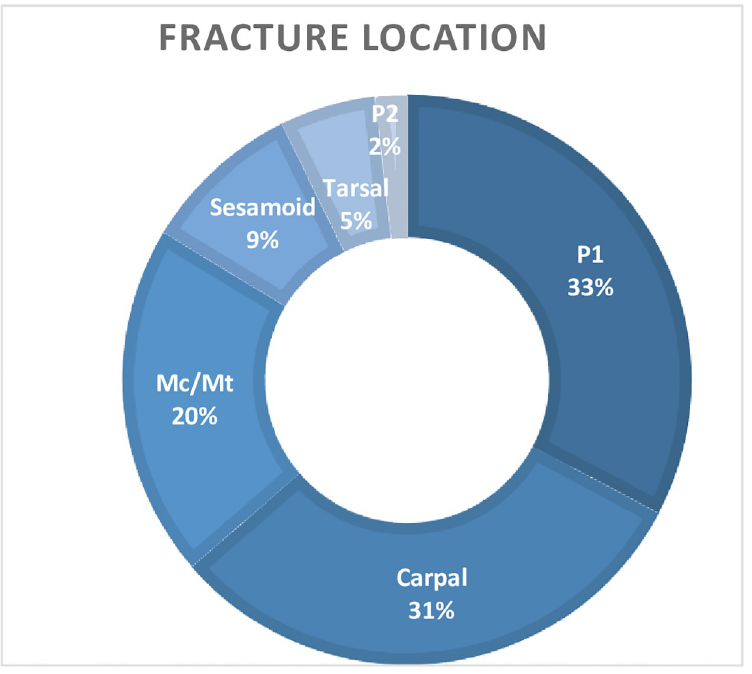
Fig 2. This chart details the distribution of fracture locations included in this